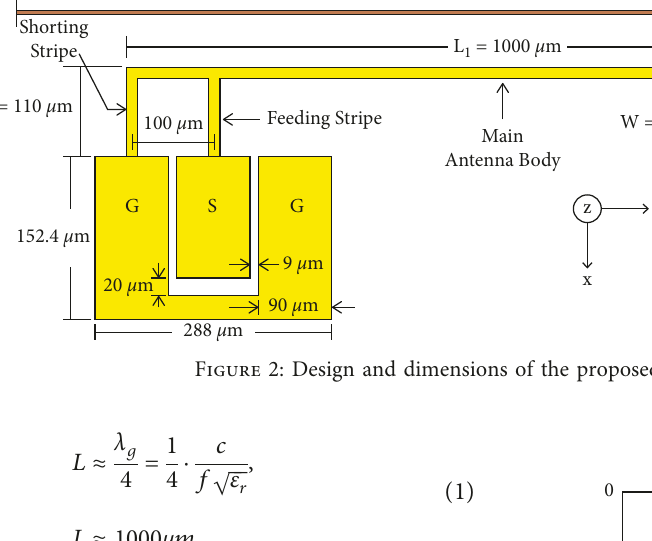
100 µ m Feeding Stripe